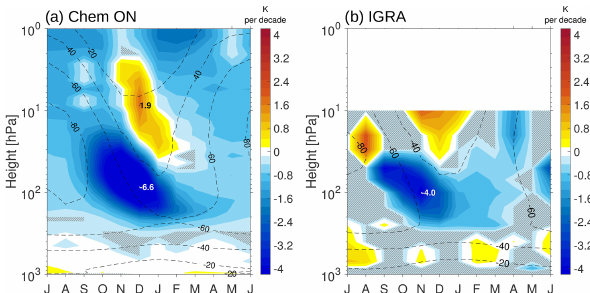
Figure 5. Polar cap (65–90 ◦ S) linear temperature trend in kelvin per decade as function of height for the ensemble mean of (a) Chem ON and (b) IGRA for the time period 1969–1998 (shading). The particular climatologies (contours) are represented for the same pe- riod with an interval of 20K. Statistically insignificant regions are hatched at the 5% level based on a Mann–Kendall